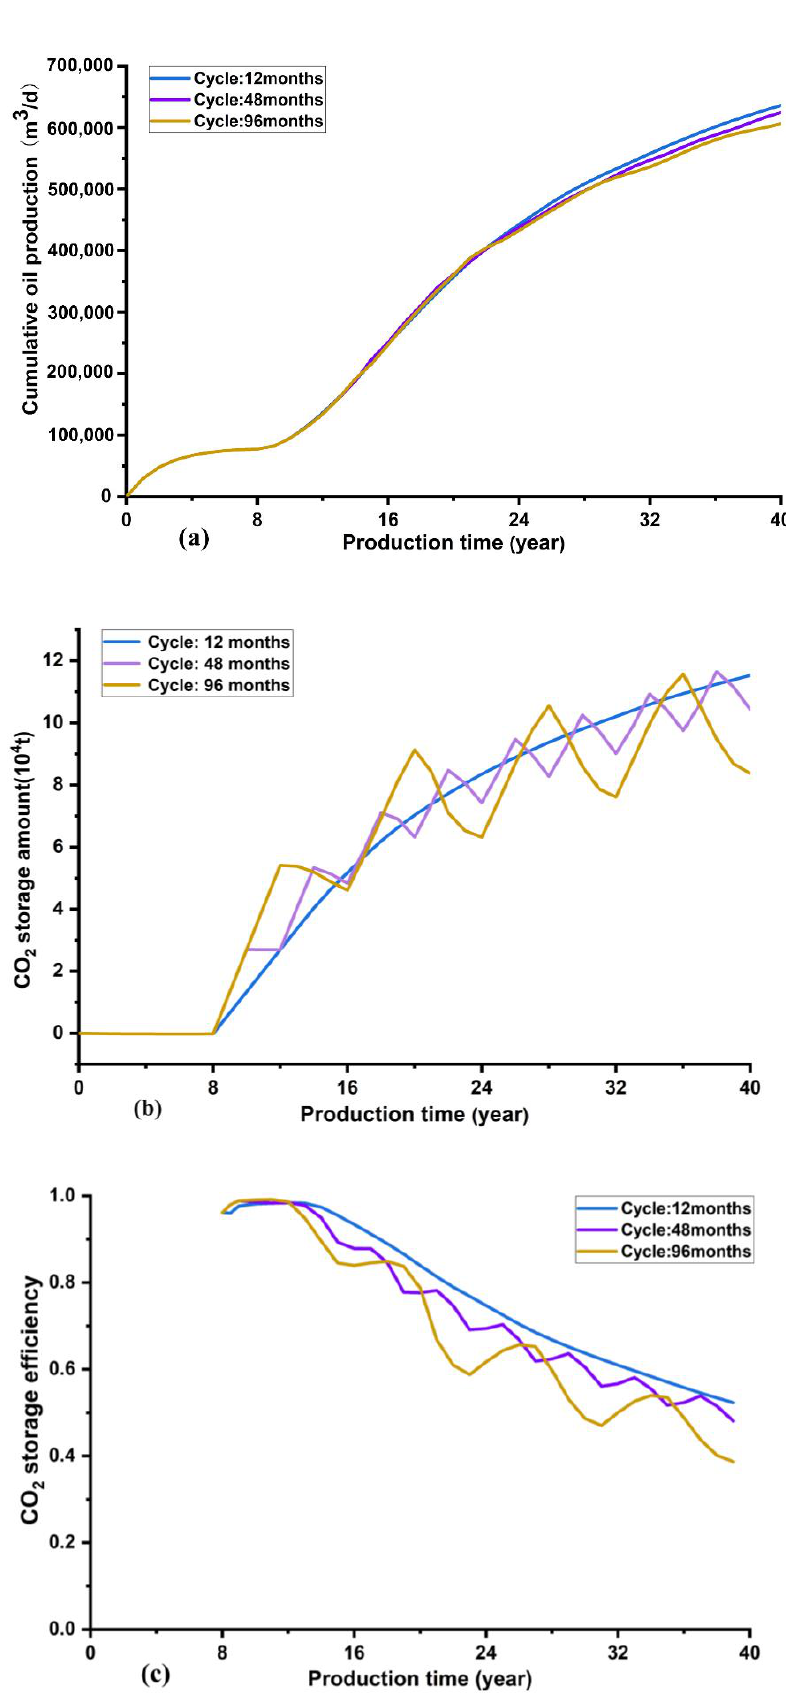
Figure 9. Effect of WAG cycle on ( a ) cumulative oil production, ( b ) CO 2 storage amount, and ( c ) CO 2 storage